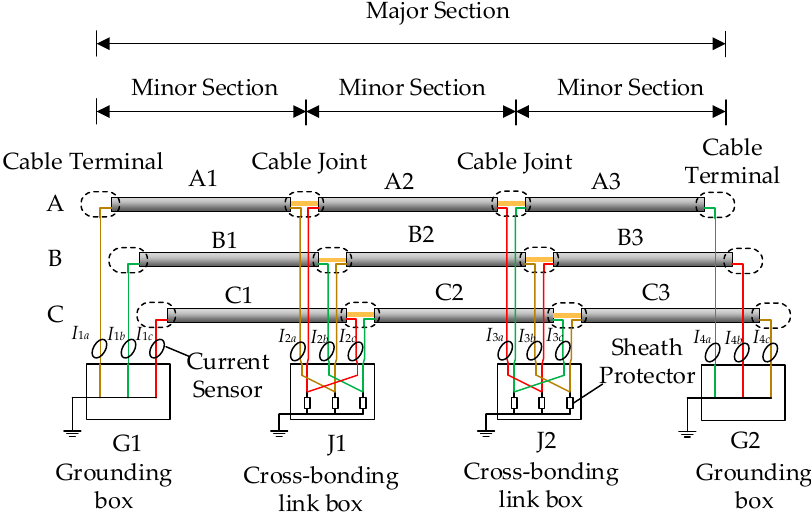
Figure 13. The schematic diagram of the cross-bonded cable circuit. ( I 1 a , I 1 b , I 1 c are, respectively, the sheath currents recorded by the current sensors of phase A, B, C at G1; I 2 a , I 2 b , I 2 c are, respectively, the sheath currents recorded in phase A, B, C at J1; I 3 a , I 3 b , I 3 c are, respectively, the sheath currents recorded in phase A, B, C at J2; I 4 a , I 4 b , I 4 c are, respectively, the sheath currents recorded in phase A, B, C at G2.).